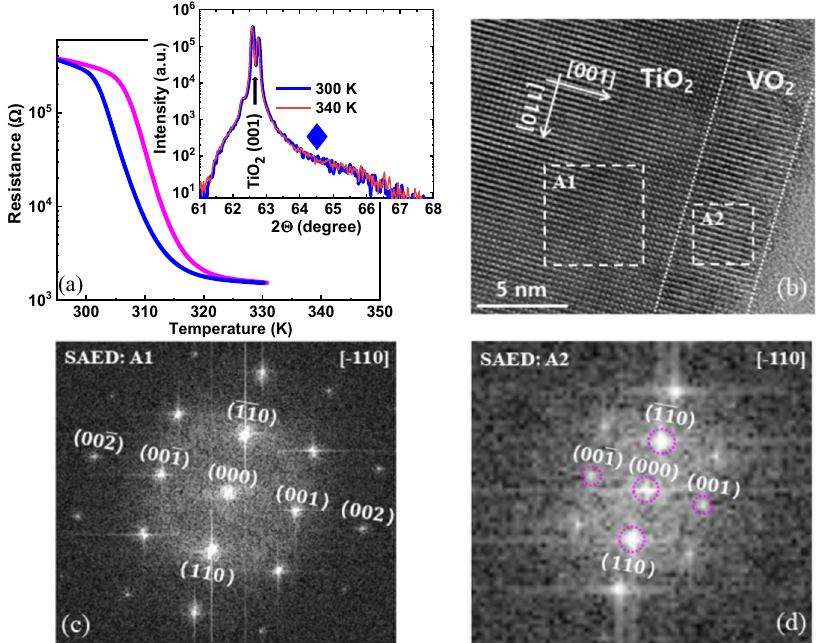
Fig. 1 Transport and structural characterization. Temperature-dependent resistance ( R ) of ultrathin VO 2 fi lm of a thickness of 7.2 nm on rutile (001) TiO 2 . The magenta and blue curves are obtained while heating and cooling the sample respectively. The inset displays the XRD curves. The blue diamond indicates a monoclinic peak position (64.55°, see Supplementary Note 3). Here, the monoclinic peak is not observed in the inset. b TEM image of the VO 2 /TiO 2 interface demonstrating clear epitaxial growth. Selected area electron diffraction (SAED) images of the white dashed rectangle (A1) in TiO 2 ( c ) and (A2) VO 2 ( d ) from TEM